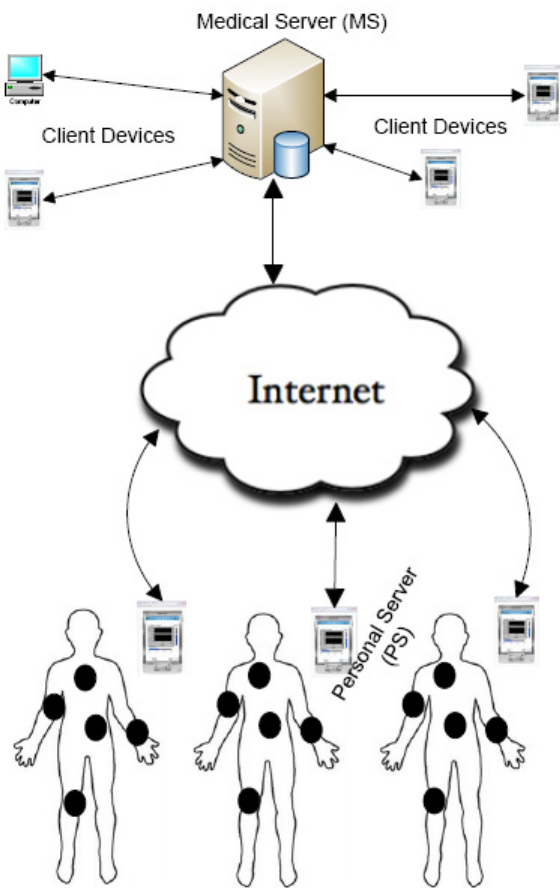
Figure 1. System architecture of wireless body area